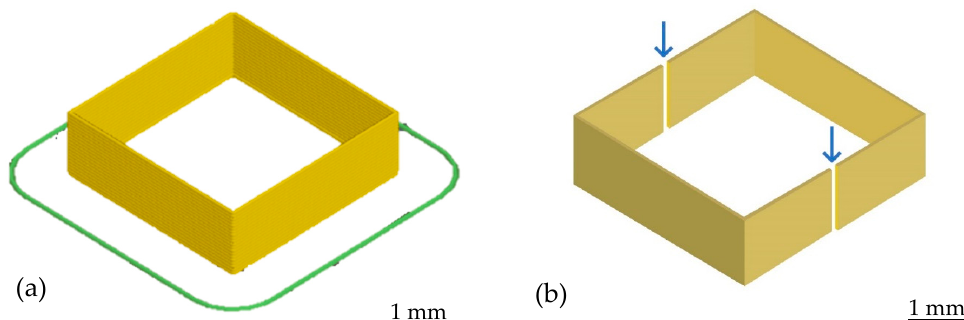
Figure 2. ( a ) 10 mm height cube model; ( b ) cross-section location of the microscopy photos.